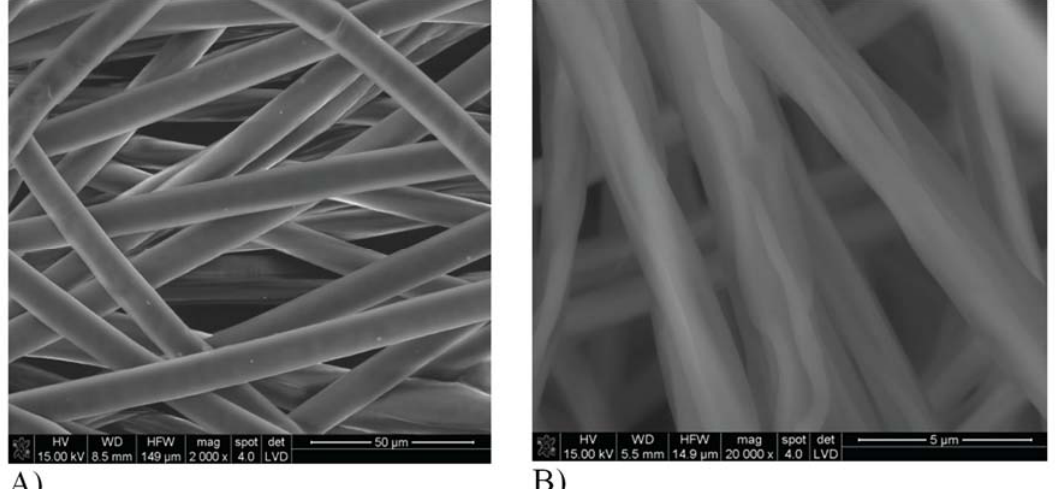
Figure 4. Morphology of fibres obtained by electrospinning. Fibres made from polycaprolactone ( A ) and dibutyryl chitin ( B